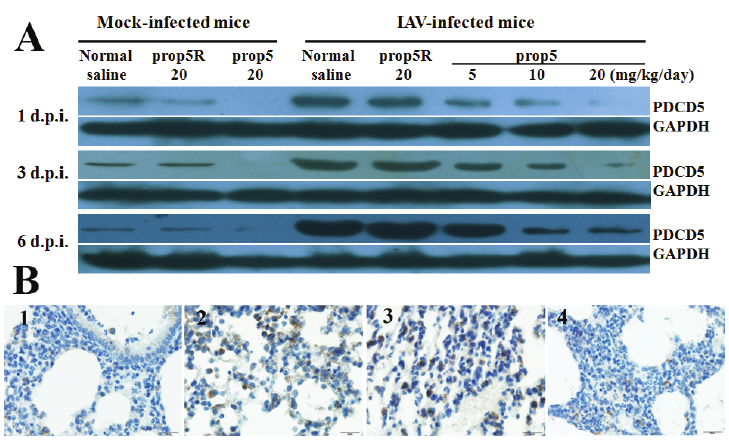
Figure 2. Prop5 down-regulated PDCD5 protein levels in mock-infected and influenza virus infected BALB/c mice ( n = 5). Mice were pretreated with ASODNs and infected with A/FM/1/47 (H1N1), or received normal saline only (mock-infected mice) in the same manner as described above. ( A ) Expression of PDCD5 protein was inhibited by prop5 in mock-infected and influenza-infected mice lung tissue. At 1, 3, and 6 d.p.i., mice lung tissue samples were prepared for detection levels of PDCD5 by Western blotting. GAPDH served as the internal control; ( B ) Immunohistochemical staining was use to detected PDCD5 protein in mice lung tissue at 6 d.p.i. Weak expression of PDCD5 was detected in lung cytoplasm of mock-infected mice (1) and prop5 (20 mg/kg/d) pretreated mouse